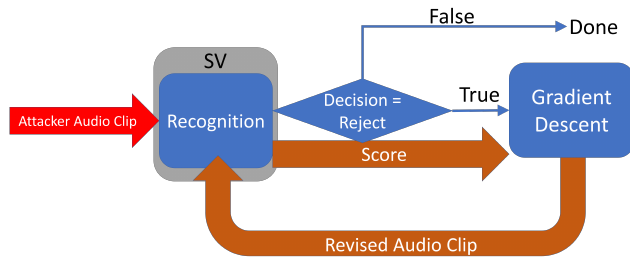
Figure 2. The process of FakeBob adversarial